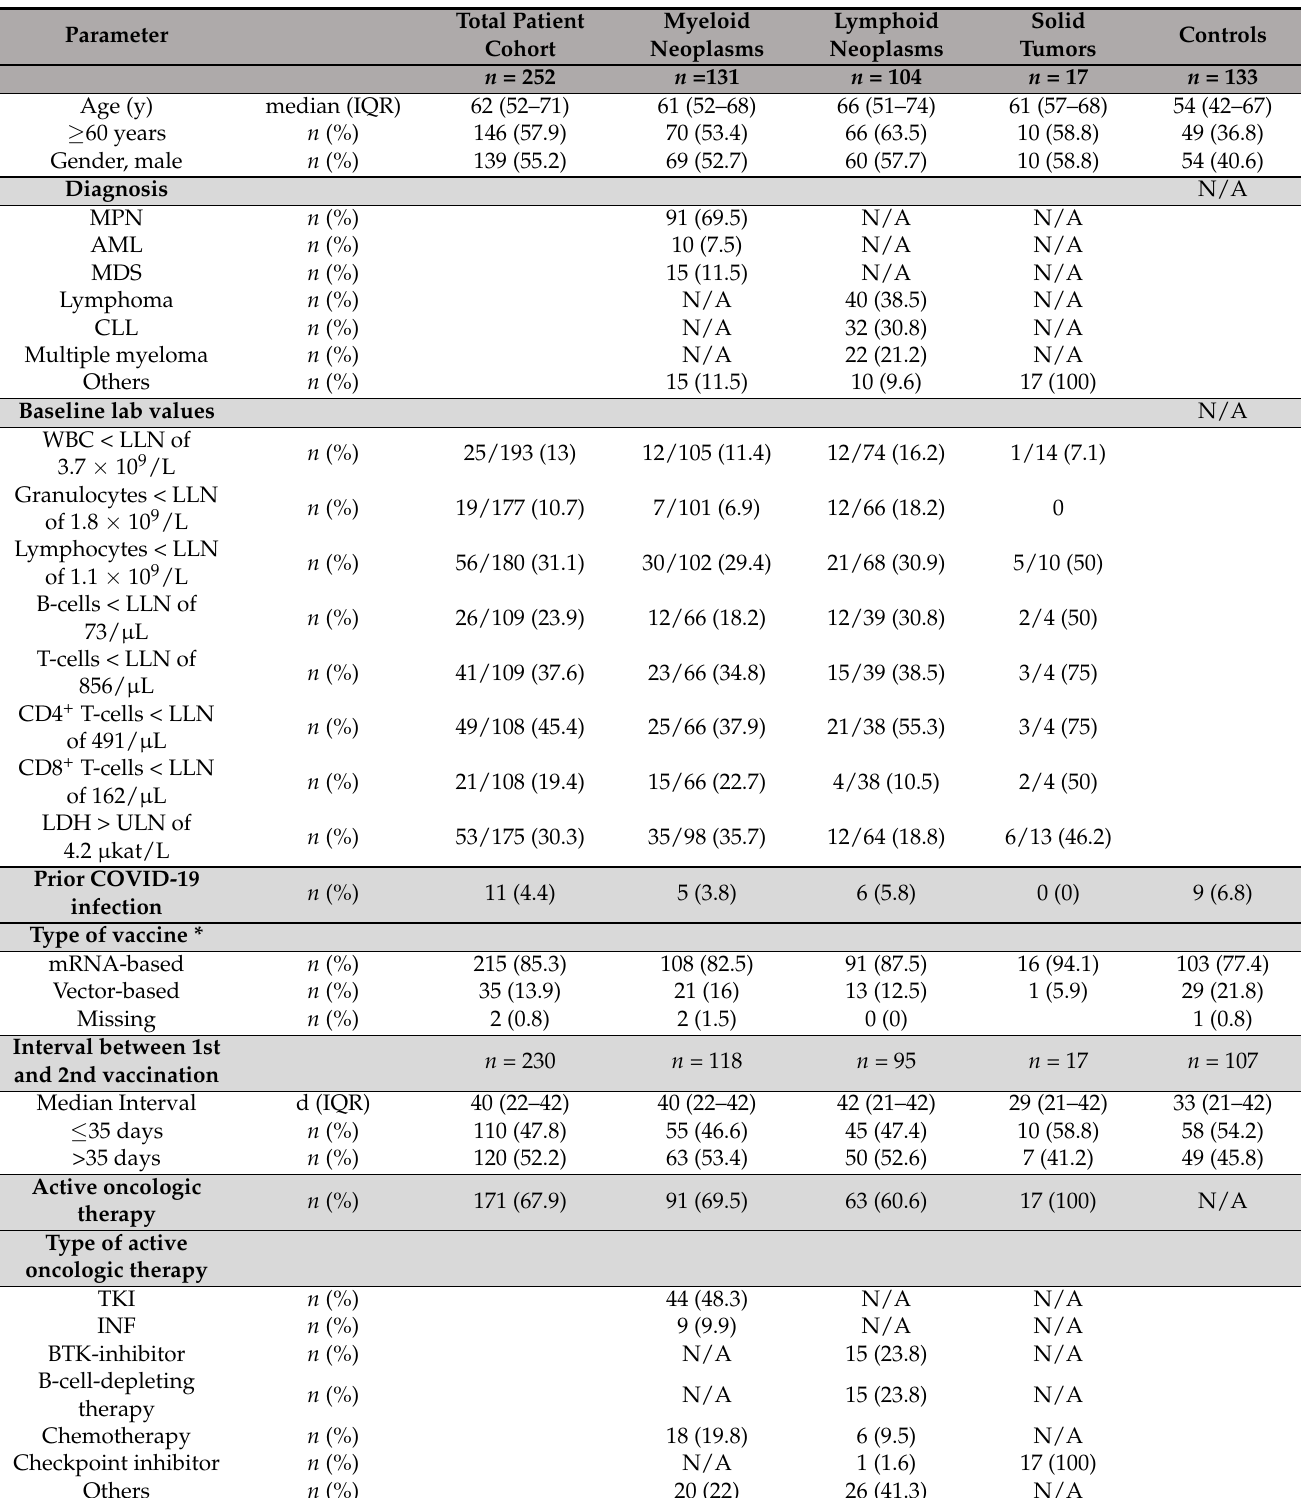
Table 2. Baseline characteristics of vaccinated study